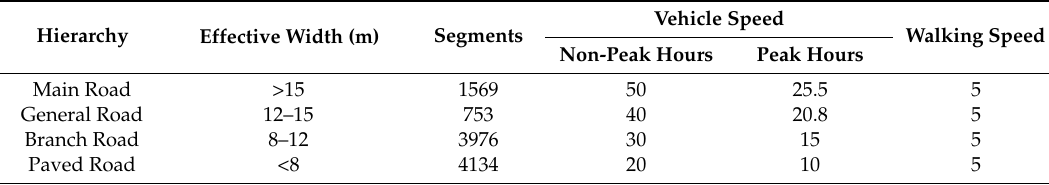
Table 2. Road Types with Their Widths and Speed Limits (unit: km/h).